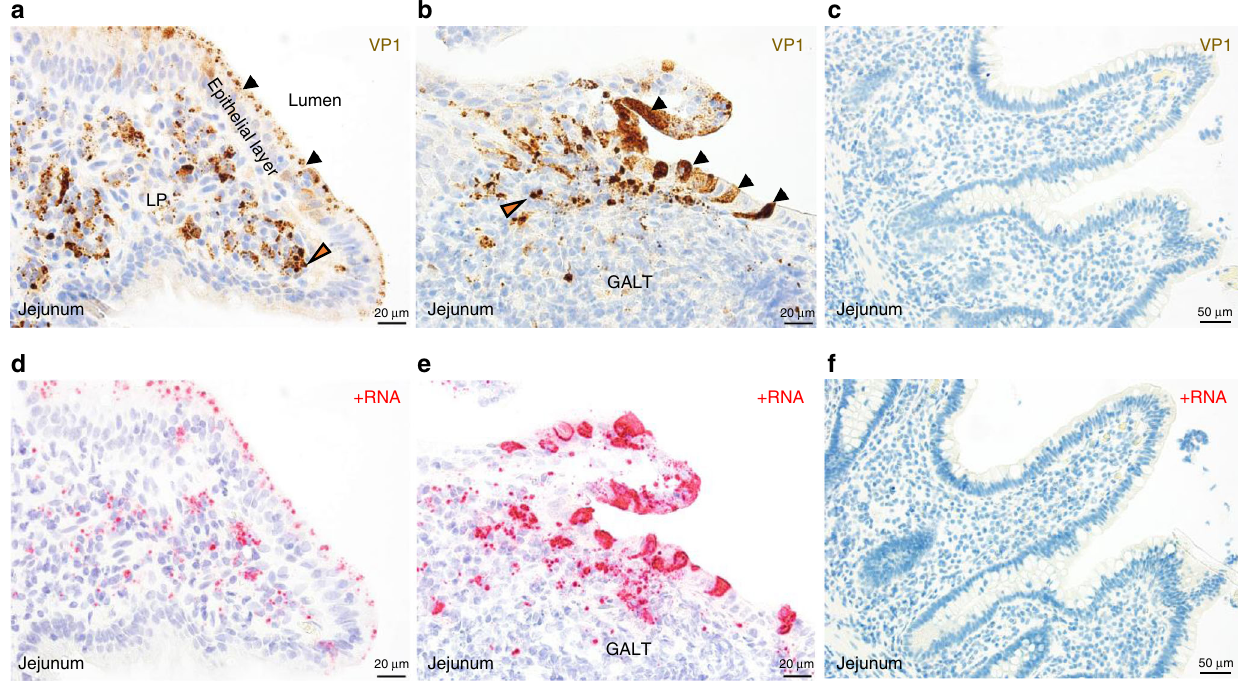
Fig. 1 Detection of norovirus in jejunal biopsy from pediatric intestinal transplant patient (GT-1). a Chromogenic staining and bright fi eld imaging with monoclonal antibody TV19 directed against the viral capsid protein (VP1) showed the presence of epithelial cells with an apical distribution of capsid antigen (staining brown) oriented toward the lumen (black arrows) as well as capsid-positive cells in the lamina propria (LP) (orange arrow). b Chromogenic staining of a different section of the same jejunal biopsy illustrated the presence of intensely stained epithelial cells above GALT (black arrows) as well as VP1-positive cells within the LP around the periphery of the GALT (orange arrow). c Chromogenic staining of jejunal biopsy from a norovirus-negative intestinal transplant patient (GT-4) with the TV19 capsid-speci fi c monoclonal antibody was included as control. d In situ hybridization (ISH) analysis of patient GT-1 jejunal biopsy to detect positive-sense viral RNA (staining red) showed distribution patterns similar to VP1 in a , with an apical orientation of viral RNA toward the intestinal lumen in epithelial cells, as well as virus-positive cells within the LP. e ISH analysis of jejunal biopsy to detect positive-sense RNA showed a distribution pattern similar to VP1 in b , with epithelial cells above the GALT and in the LP on the periphery of GALT displaying positive reactivity. f Positive-sense RNA probe hybridized with jejunal biopsy from norovirus-negative transplant patient (GT-4) as control. (Magni fi cations: a, b, d and e 40×; c and f